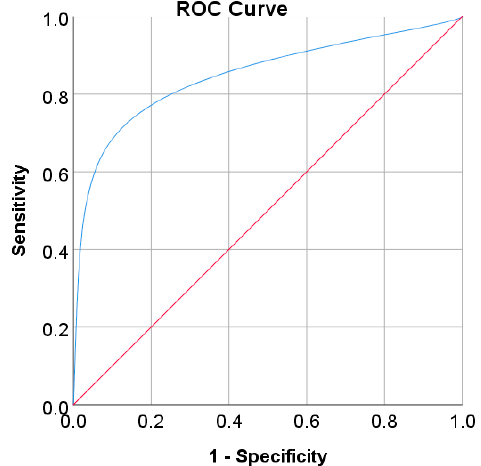
Figure 9. ROC curve for FBS values as a screening test on the Korean adult population; FBS was used as the gold standard; the straight line represents the reference line.